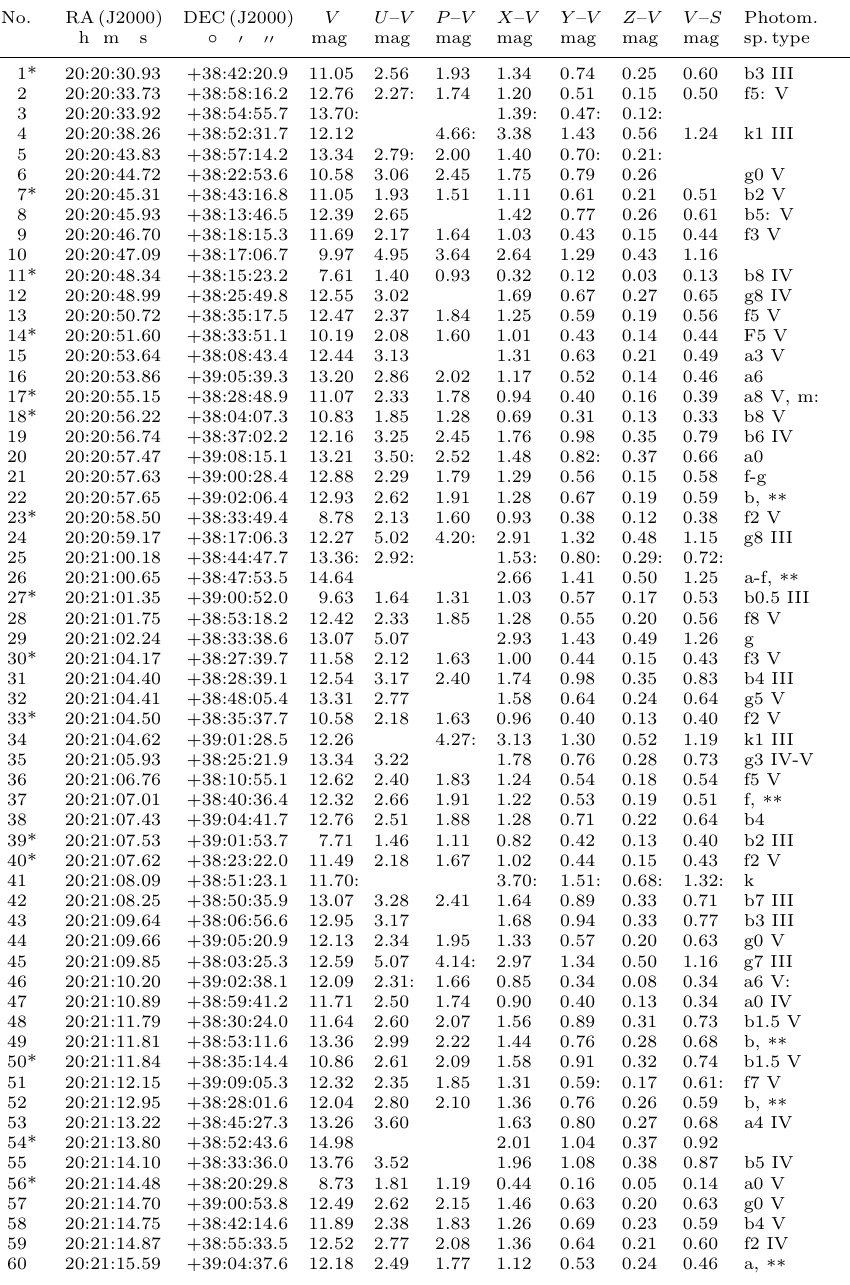
Table 2. Results of photometry and classification of stars in the M 29 area. The stars with two asterisks in the last column were not classified since their images are asymmetrical, i.e., these stars are double or multiple.